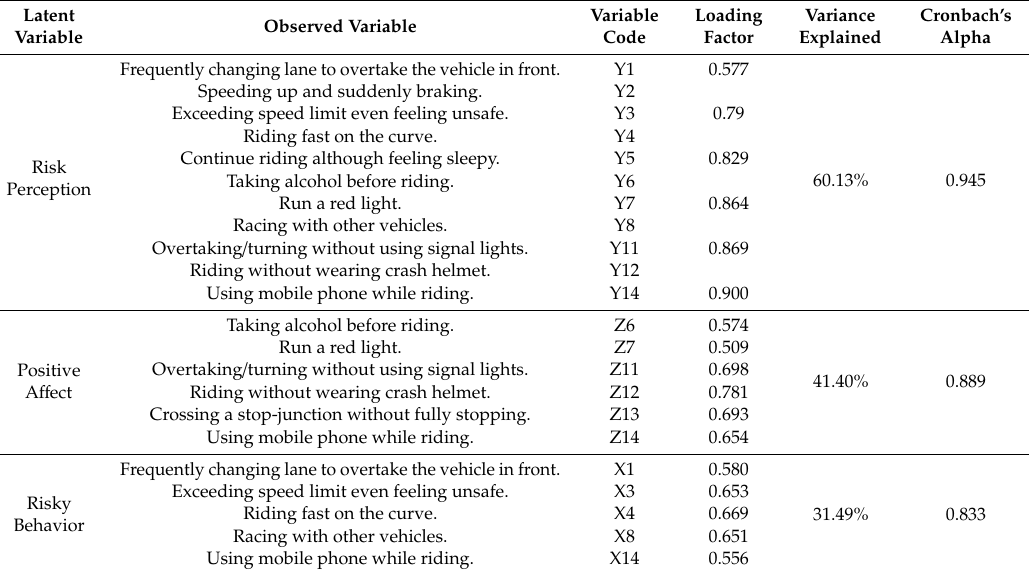
Table 4. Variables and reliability analysis of latent and observed